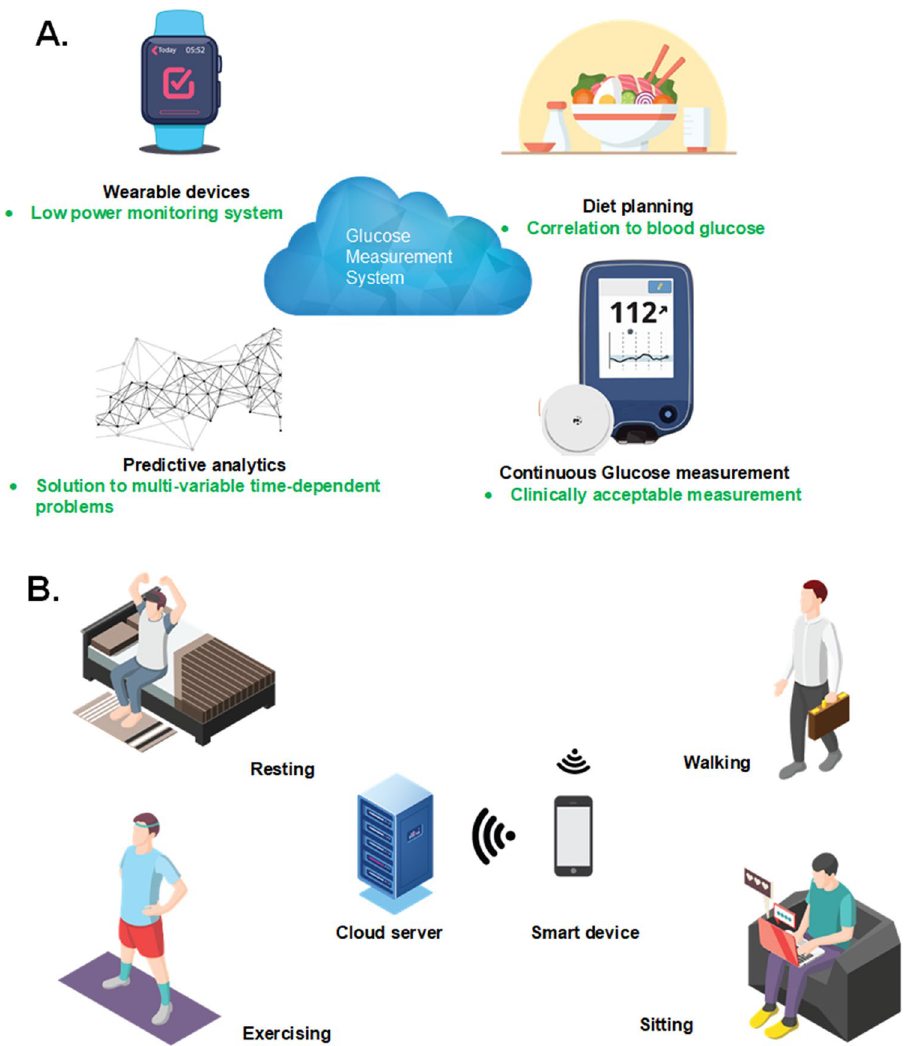
Figure 1. ( A ) Glucose monitoring system overview and its components. ( B ) Examples of some of the activities that can be performed by wearing a glucose monitoring